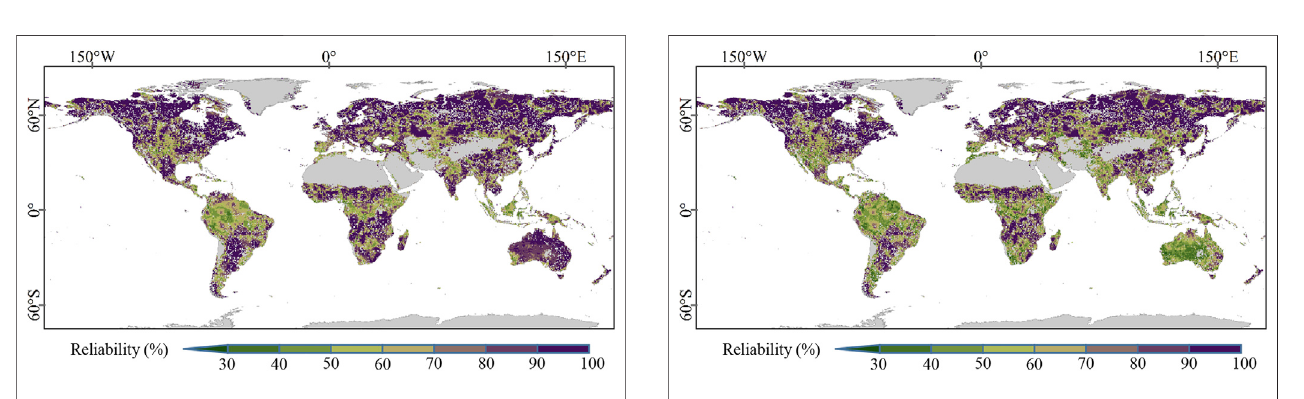
FIGURE 5 | Global reliability pattern of accumulated months obtained from probability